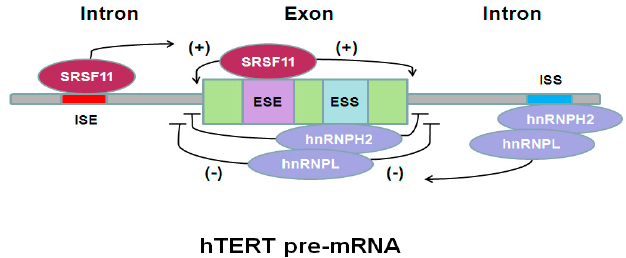
Figure 2. Control of hTERT pre-mRNA alternative splicing. SRSF11 (one of the serine-arginine repeat SR proteins) can act to promote splicing by interacting with the splicing enhancers. hnRNPH2